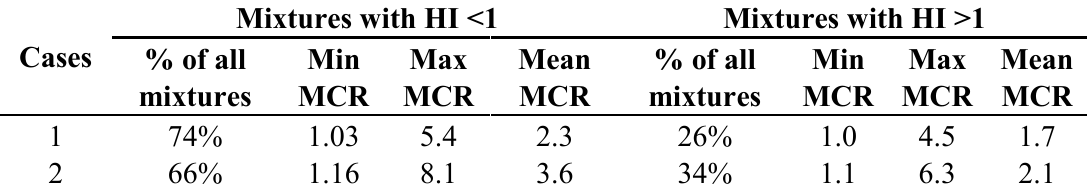
Table 7. Comparison of MCR values for mixtures with HI values greater or less than 1.